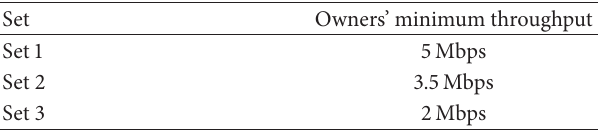
Table 2: Owners’ minimum throughput.